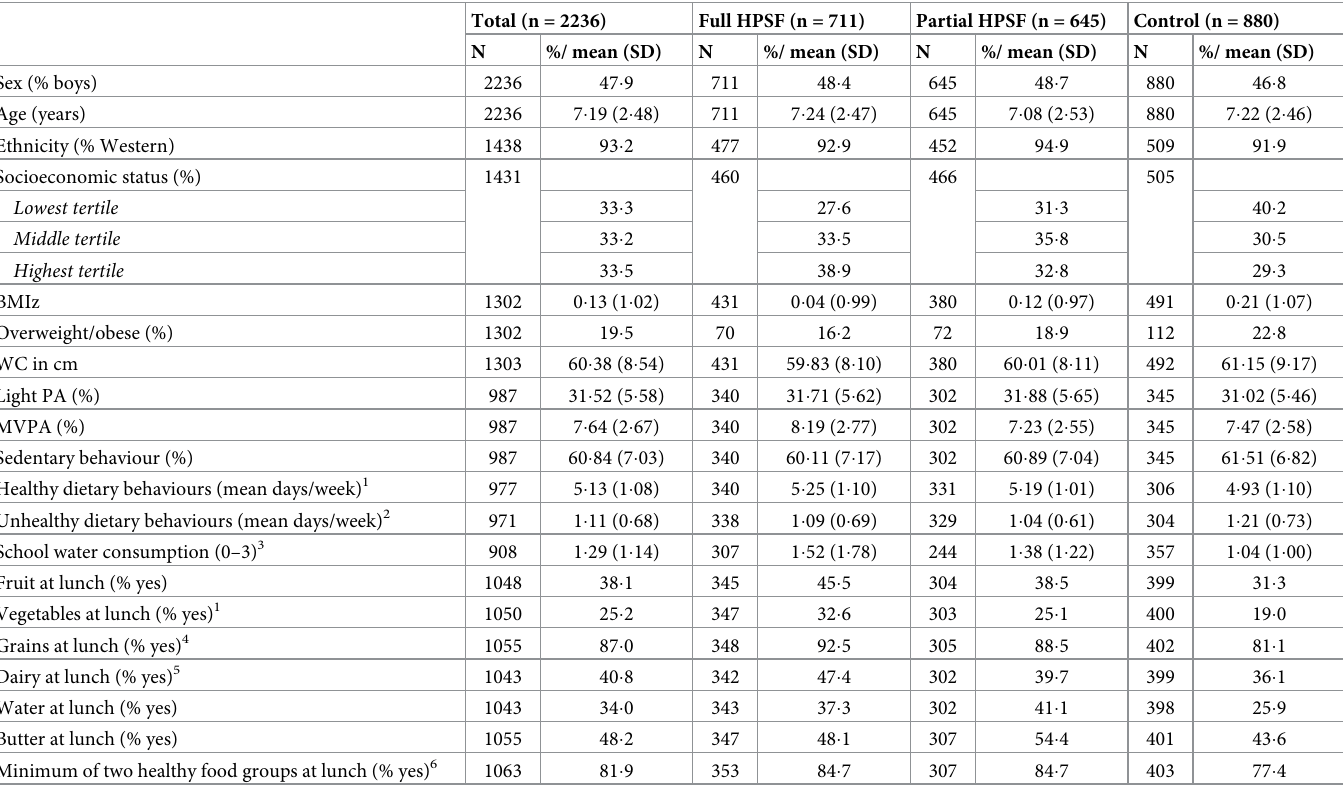
Table 2. Characteristics of the participants at baseline